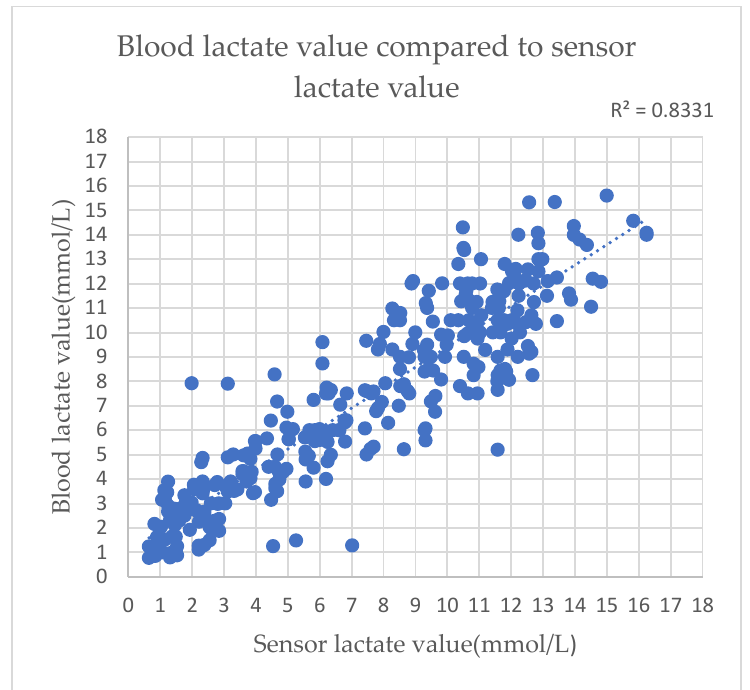
Figure 21. Human experiment data: the data obtained using a lactate sensor show a positive correlation with blood lactate levels.